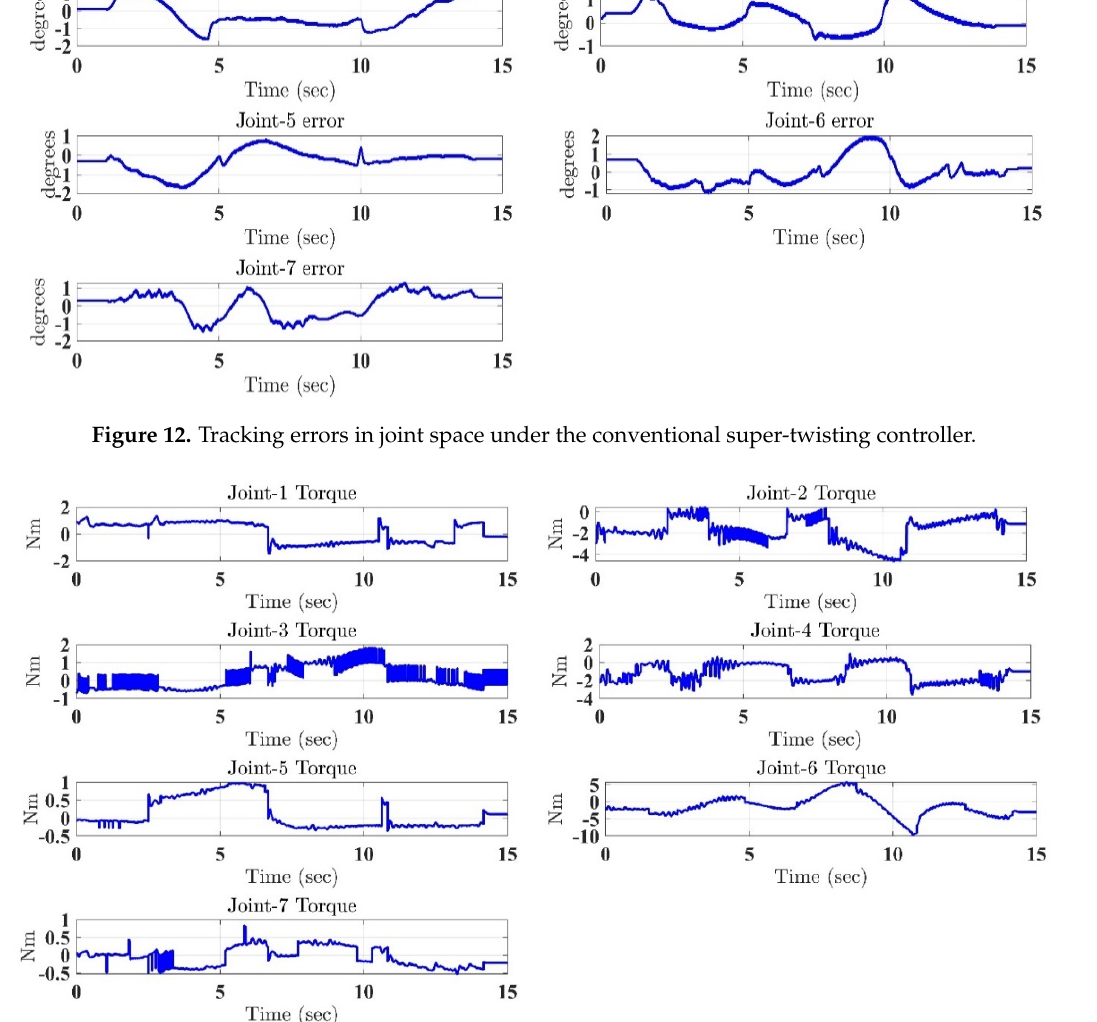
Figure 13. Control inputs under the conventional super-twisting controller.